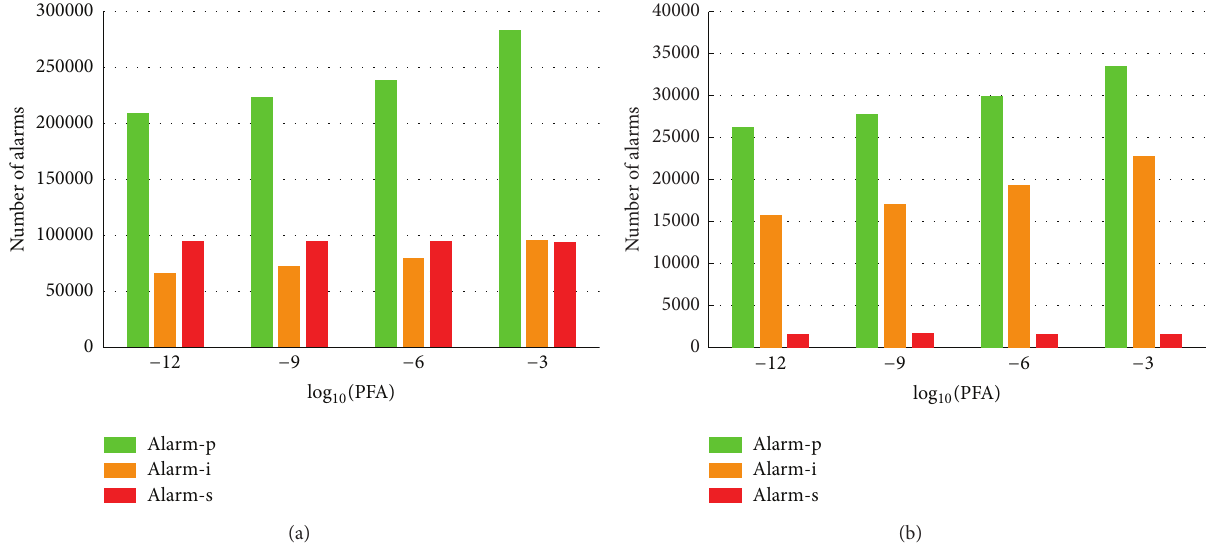
Figure 10: Number of alarms versus PFA, for different types of alarms, in Font Roja (a) and Ayora (b).